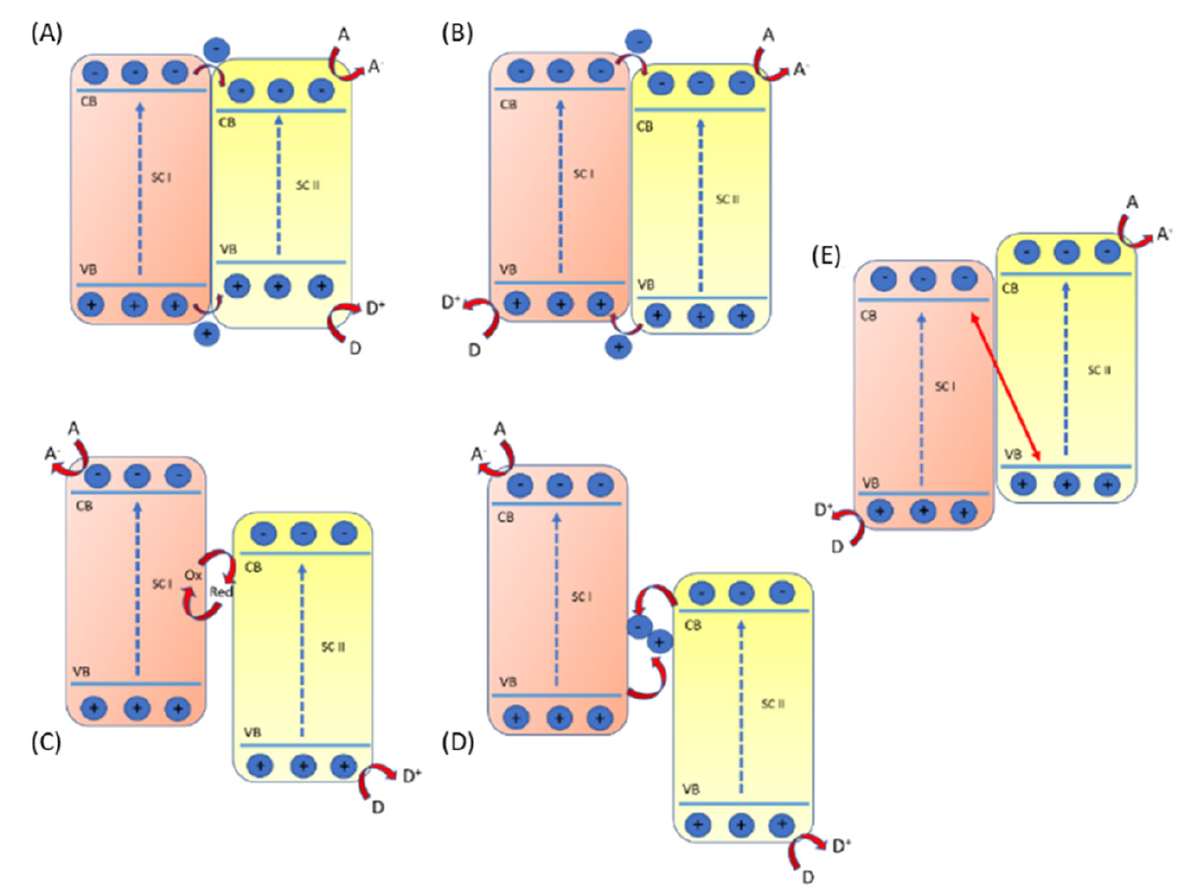
Figure 9. Heterostructures. ( A ) type − I ( B ) type − II ( C ) Z − scheme with redox mediator ( D ) all solid Z − scheme ( E ) S −